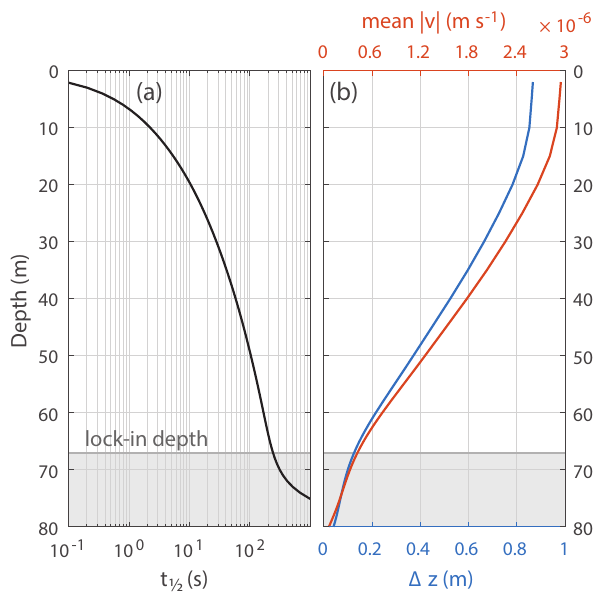
Figure 4. Firn air pressure response at the WAIS Divide site. (a) Re- (z) to a unit-step surface forcing. (b) The 2 σ air dis- sponse time t 1 / 2 placement (cid:49)z as a function of depth (blue), and the mean absolute air velocity due to barometric pumping (red), both forced by the 2010 surface pressure time series (Fig.